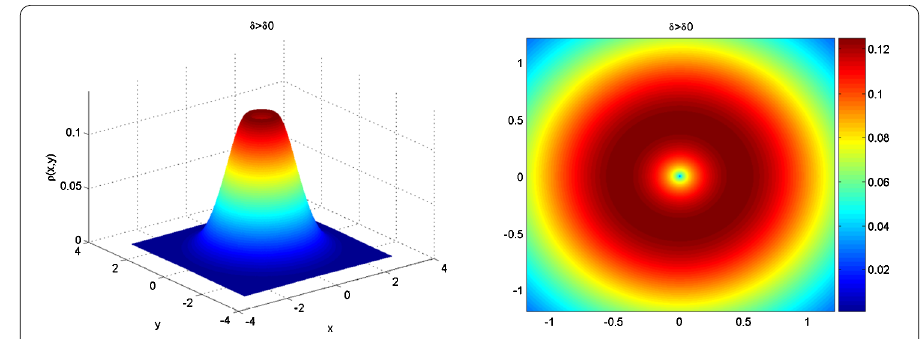
Figure 6 Portraits of (cid:21) ( x , y ) (left) and distribution of invariant densities (right) when A = 1, B = 1.88, δ = 0.5898979486 > 0.4898979486 = δ